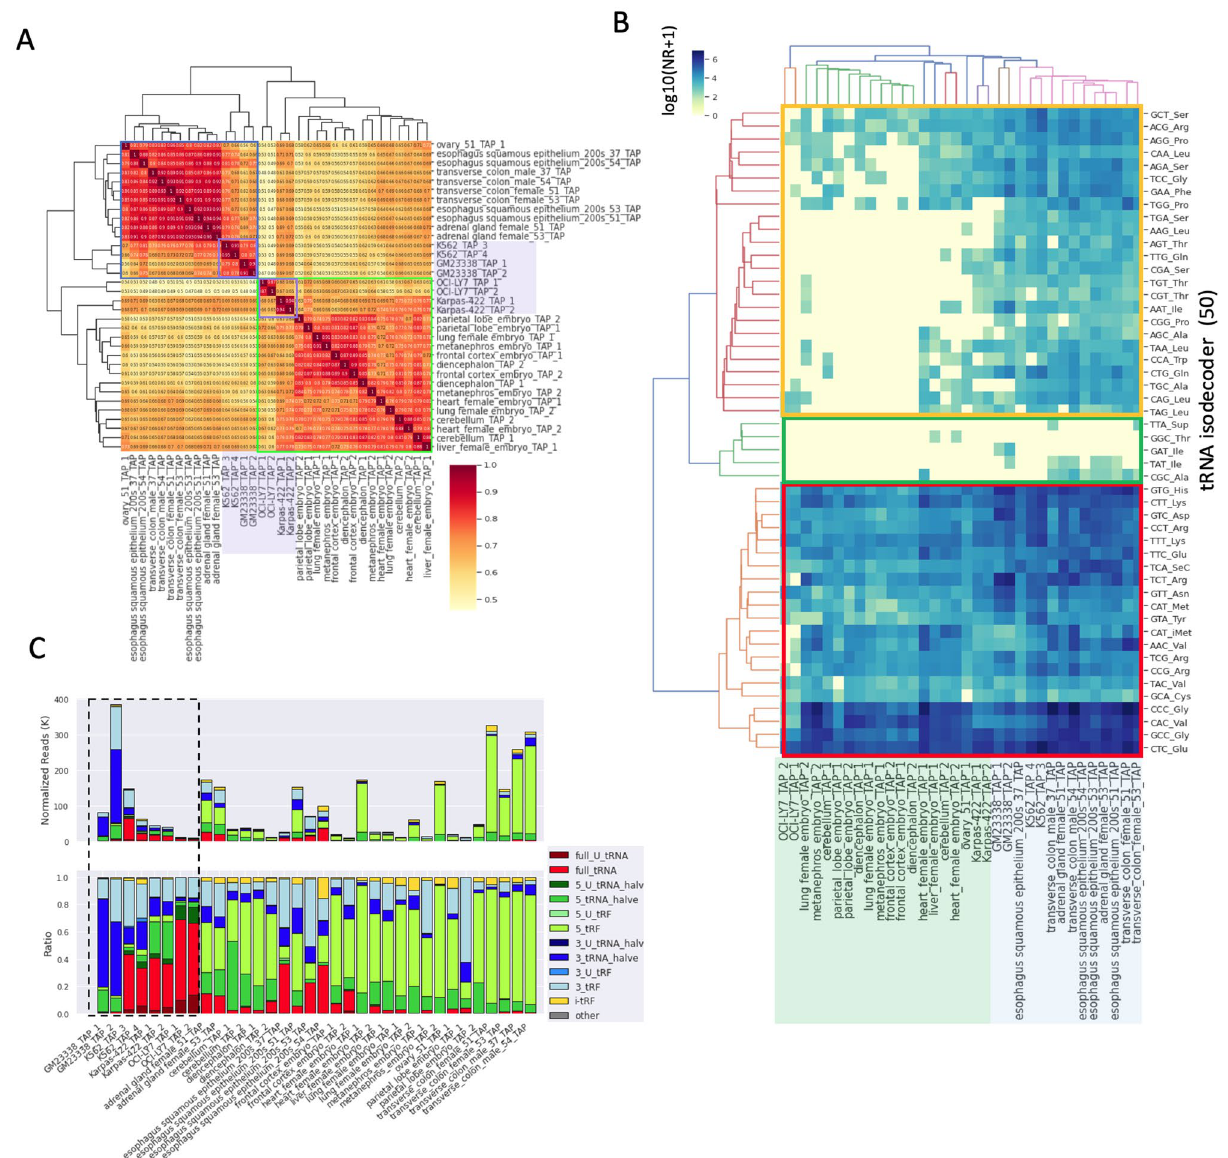
Figure 4. tRNA expression profiles in the cell line and tissue data. ( A ) The correlation matrix of the expression profiles of tRNA families across 34 samples. Two major clusters are highlighted by blue and green rectangles. The light purple rectangles indicate the cell line samples. ( B ) Clustered heatmap of 50 tRNA isodecoders across the samples. The expression levels of isodecoders are represented by log10(NR + 1), and the three major clusters are marked by color rectangles (red, yellow, and green rectangles represent universally expressed tRNA isodecoders, tissue-specific expressed isodecoders, and nonexpressed isodecoders, respectively). Group 1 and Group 2 samples in ( A ) are marked with light green and blue rectangles at the bottom in ( B ). ( C ) Stack bar charts showing the relative abundance and composition of tRFs in all samples. The top and bottom panels represent the relative abundance (NR) of tRNAs/tRFs and the proportions of tRFs in the samples, respectively. tRFs are colored as shown in the legend. The dot black rectangle indicates cell line respectively. In GM23338 and OCI-LY7 cells, the ratios of G −1 addition were even lower (15% and 19%, respec- tively) (Fig. 5A). These data suggest that the Thg1 pathway may be interrupted in these cell lines. Analysis of the ratio of the 5 ′ -halves of tRNA His indicated that the G −1 addition ratios of the 5 ′ -halves were significantly lower (approximately 15–70%) than that of full-length tRNA His in both cell lines and tissues, with the exception of GM23338, which showed a slight increase. Moreover, T −1 additions were found in 5 ′ -halves in some tissues (e.g., cerebellum, diencephalon, lung, embryo metanephros, and parietal lobe) (Fig. 5B). In the case of 3 ′ -halves of tRNA His , almost no G −1 additions were found in any of the samples (Fig. 5C). However, T −1 additions were found in all three cell lines and some tissues, such as the cerebellum, esophagus, and lung. Previous reports indicates that G −1 addition is detected only in full-length tRNA His34 . Our date suggested that the 5 ′ -halves of tRNA His may